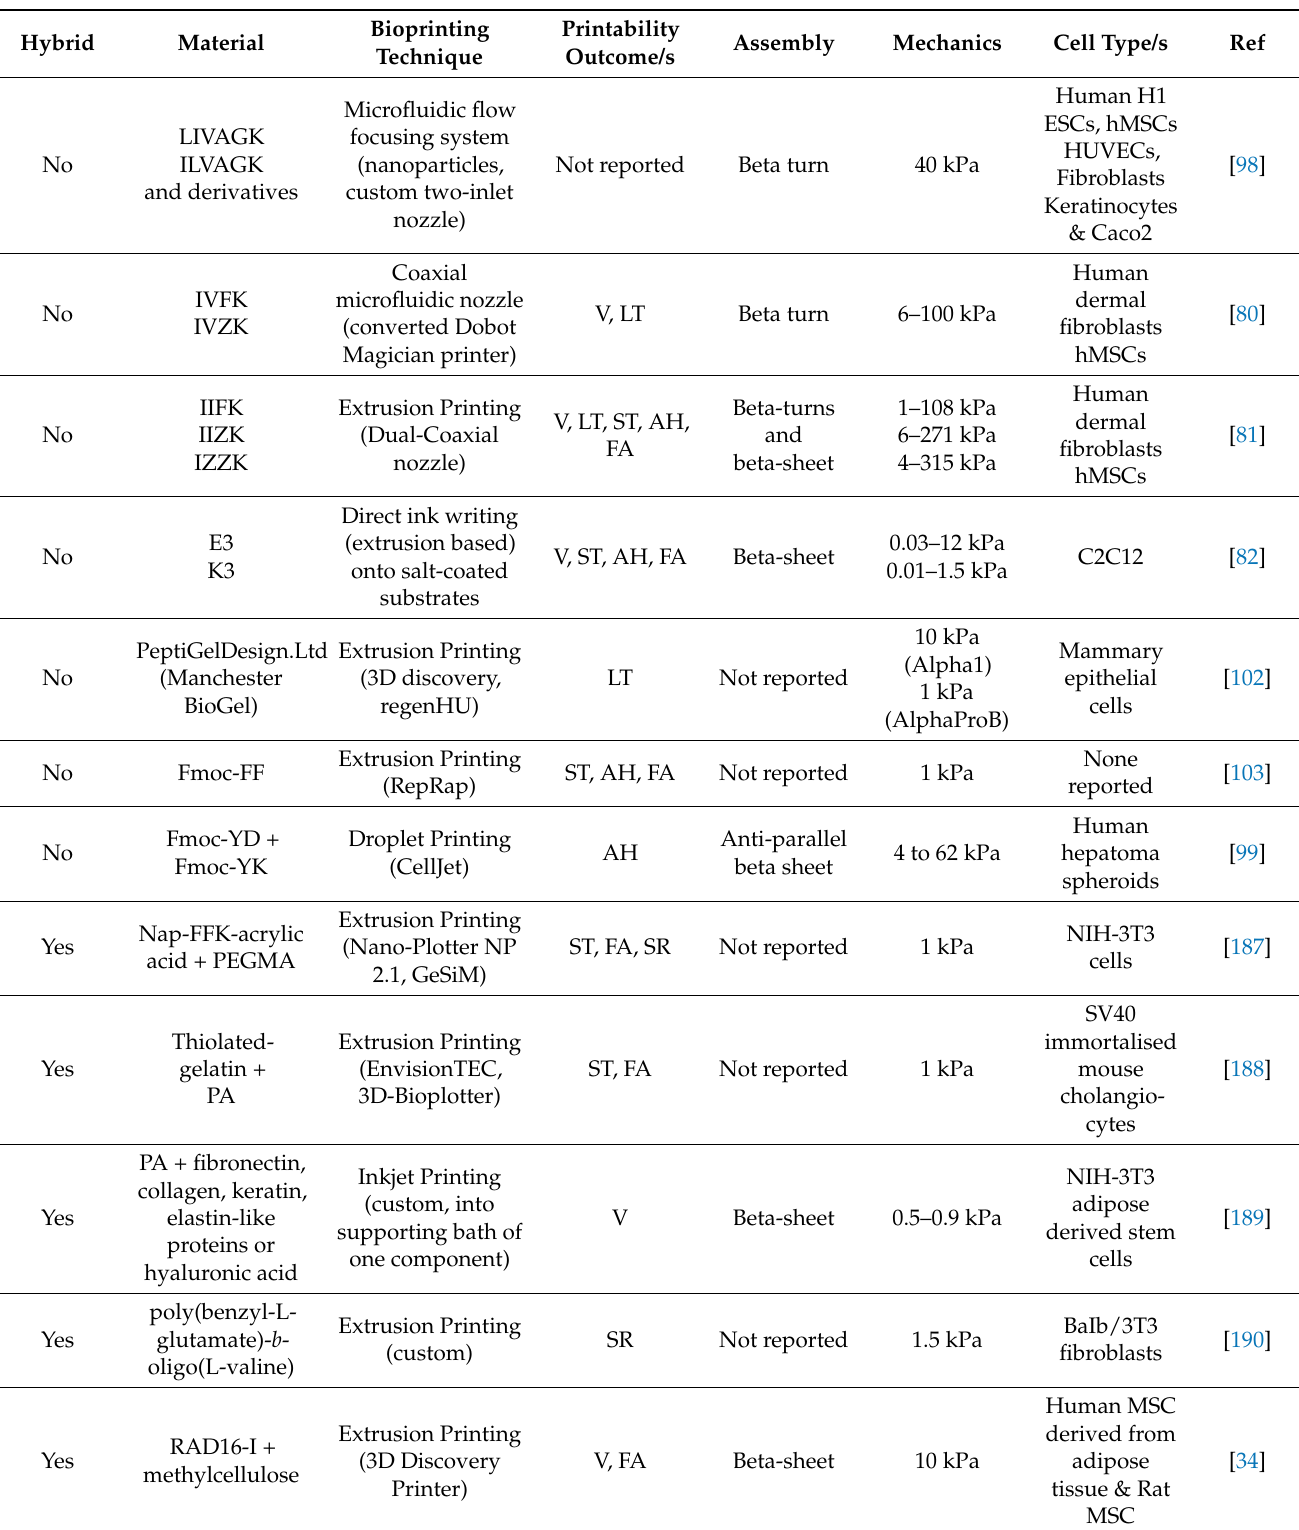
Table 1. Summary of SAP bioink materials, bioprinting techniques, printability outcomes, assembly, mechanics and cell types that were